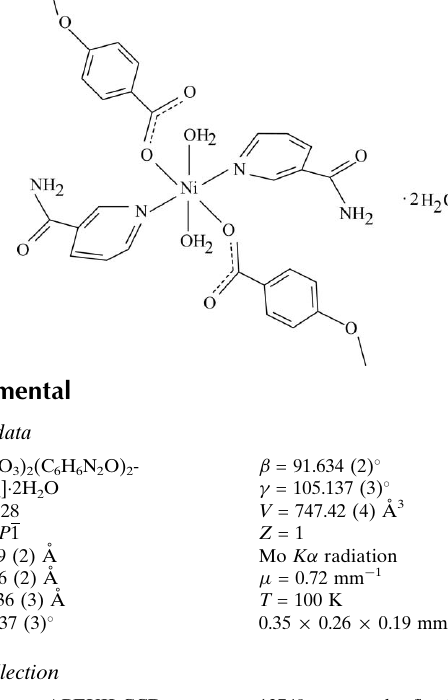
Data collection